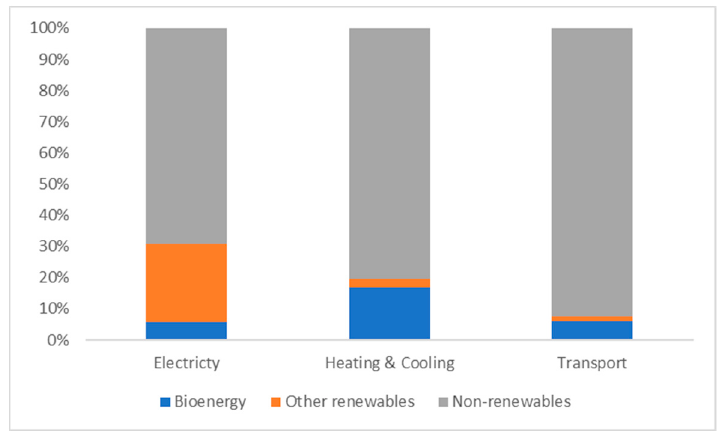
Figure 1. Final energy use in the EU28 by sector and source [7].